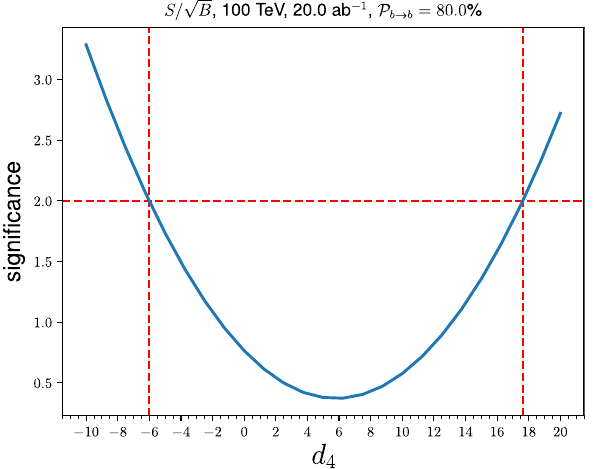
Fig. 13 ThesignificanceforouranalysisoftripleHiggsbosonproduc- tion in the ( b ¯ b )( b ¯ b )( b ¯ b ) final state with modified quartic self-coupling ( λ 4 = λ SM ( 1 + d 4 ) ) and no modification to the triple self-coupling ( c 3 = 0) at the FCC-hh at 100 TeV. We have assumed an integrated luminosity of 20 ab − 1 and b -tagging of 80%. The red dashed lines indicate the 2 σ points for the constraints on d